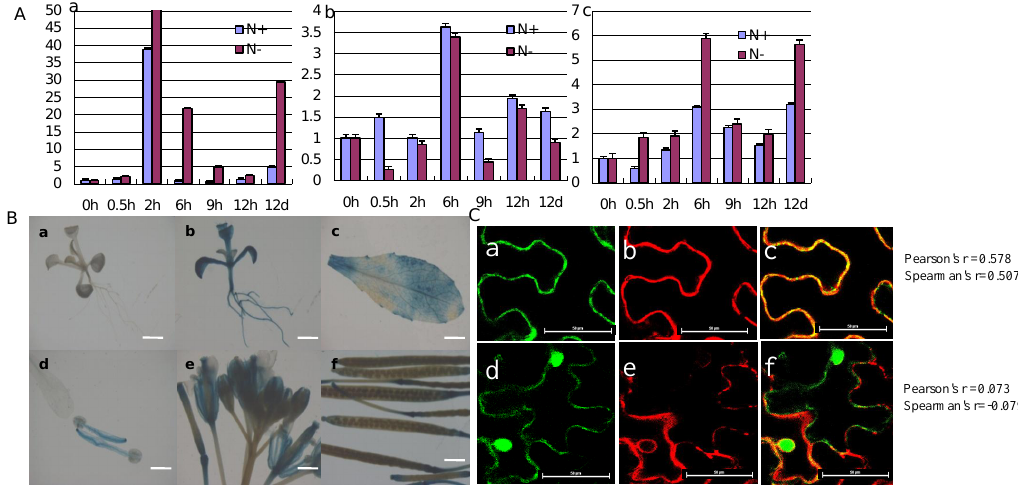
Figure 5. Expression patterns of GmCBS21 and subcellular localization of GmCBS21 . ( A ) Relative expression profiles of soybean GmCBS21 in various organs. Soybean seedlings (Pohuang) were treated with normal nitrogen (N+) and low nitrogen (N ´ ); samples were taken at different time (after treatment 0, 0.5, 2, 6, 9, 12 h, 12 days). ( a ) Relative expression profiles of soybean GmCBS21 in leaves; ( b ) Relative expression profiles of soybean GmCBS21 in stems; ( c ) Relative expression profiles of soybean GmCBS21 in roots. N+ was basic Hoagland’s nutrient solution. N ´ was basic Hoagland’s nutrient solution with 1/10 N concentration. Three independent experiments were performed, and values are shown as means and error bars indicate standard deviation ( n = 3); ( B ) Expression of the GmCBS21:GUS reporter gene in transgenic Arabidopsis plants. ( a ) Expression of the GmCBS21:GUS reporter gene in seedlings of wild type; ( b ) Expression of the GmCBS21:GUS reporter gene in transgenic seedlings; ( c ) Expression of the GmCBS21:GUS reporter gene in transgenic leaf; ( d ) Expression of the GmCBS21:GUS reporter gene in transgenic stamens; ( e ) Expression of the GmCBS21:GUS reporter gene in transgenic flower; ( f ) Expression of the GmCBS21:GUS reporter gene in transgenic siliques; Scale bars: 1 cm ( a – c ); 1.5 cm ( d , e ); 0.5 cm ( f ); ( C ) Subcellular localization of the GmCBS21 protein. Subcellular localization of the fused pJG053-35s::GmCBS21 -GFP in tobacco leaves cells. The pJG053::GFP construct was used as the control. ( a ) Green Fluorescent Protein (GFP )channel showing GmCBS21::GFP expression; ( b ) Red Fluorescent Protein (RFP) channel showing pm-rk CD3 mCherry marker expression; ( c ) co-localization of GmCBS21::GFP with the pm-rk CD3-1007 mCherry marker; ( d ) GFP channel showing pJG053::GFP expression; ( e ) RFP channel showing pm-rk CD3 mCherry marker expression; ( f ) co-localization of pJG053::GFP with the pm-rk CD3-1007 mCherry marker. Statistical analysis of the co-localization was done using Pearson’s (rP) and Spearman’s (rS) correlation factors [16]. Bar = 50 µ